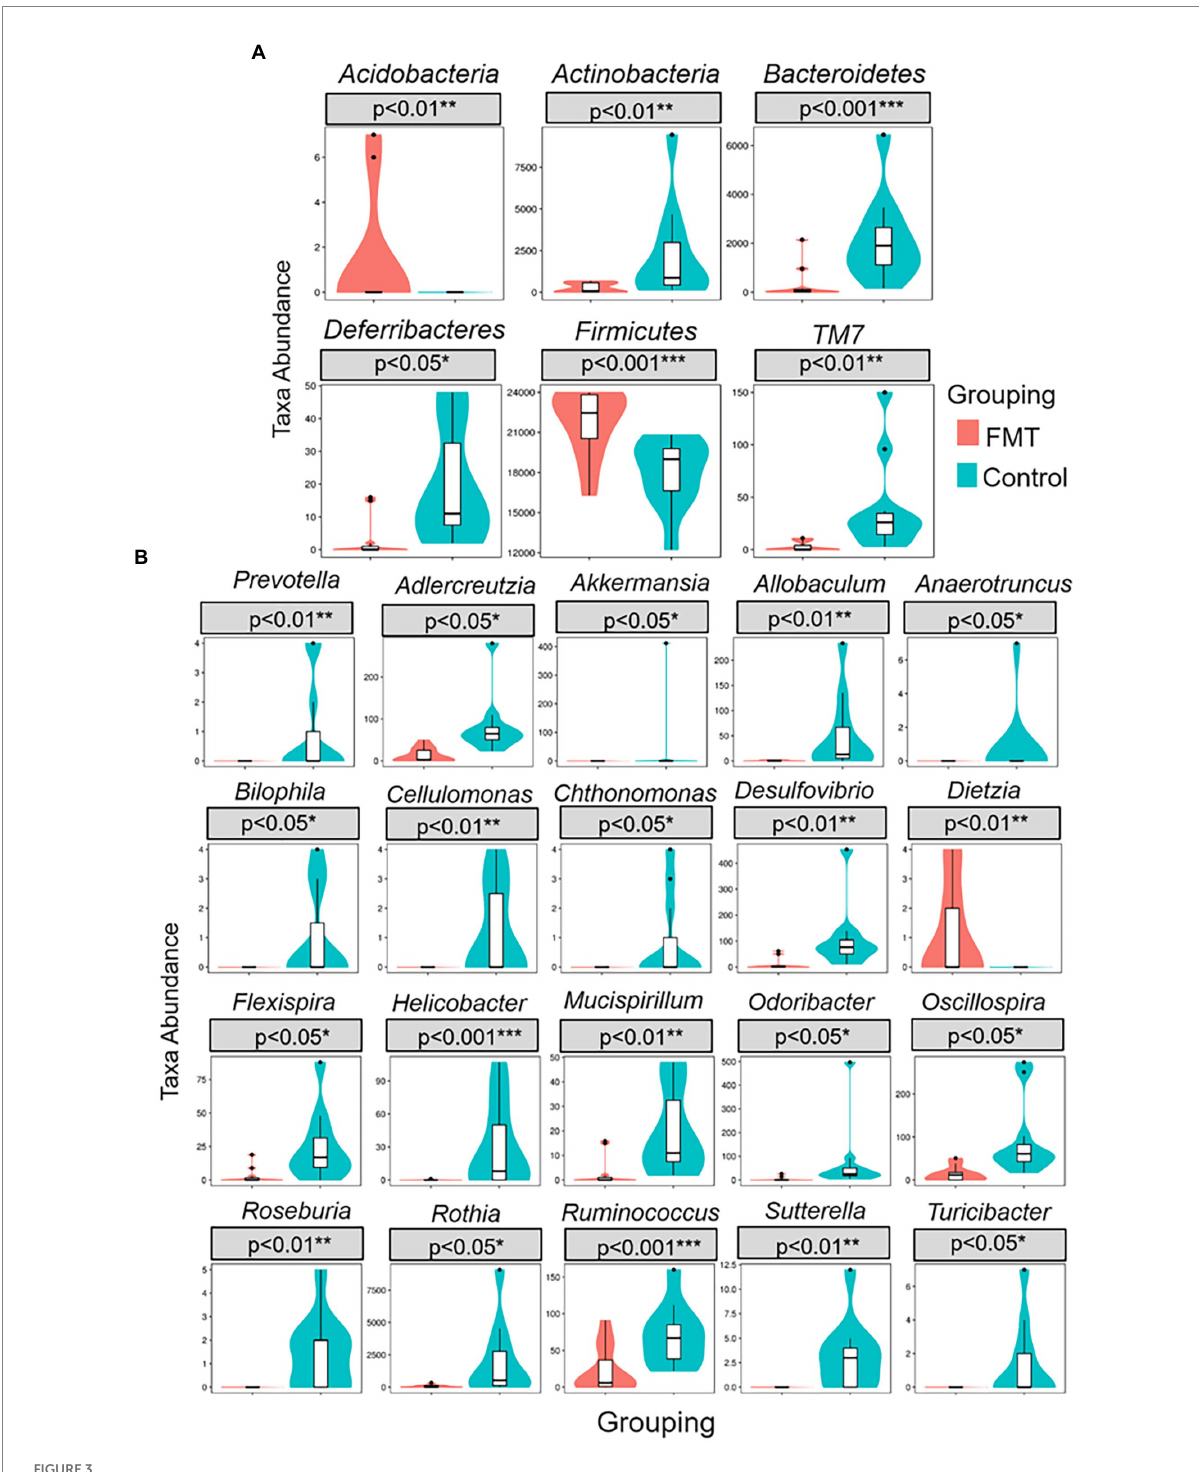
FIGURE 3 Metastats comparison statistics test for significant differences of taxa abundance between groups of control and FMT chicks. (A) six phylum (B) twenty genus presented higher F/B ratio in FMT compare with control